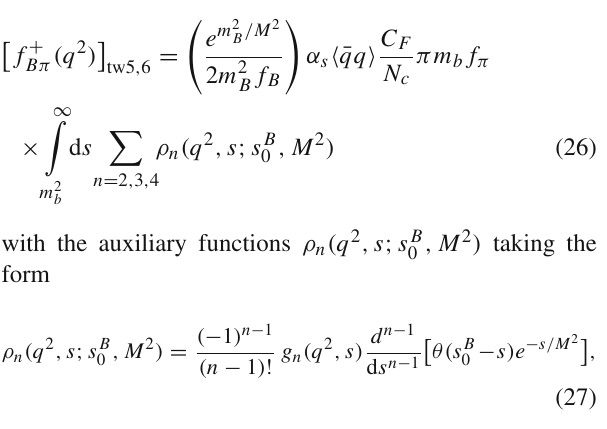
Table 1 The values of the B → π form factor at two typical values q 2 = 0 and q 2 = 10 GeV 2 and the partial contributions to the